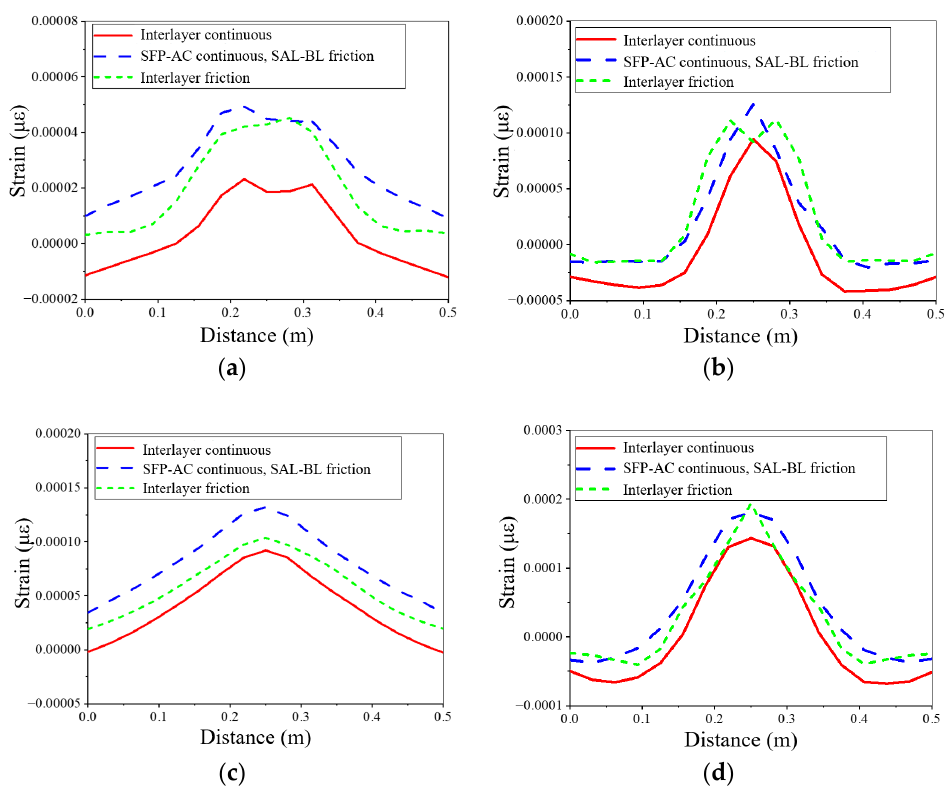
Figure 18. The effects of interlayer conditions on the dynamic responses of ART pavement. ( a ) The longitudinal strain at the bottom of SFP. ( b ) The transverse strain at the bottom of SFP. ( c ) The longitudinal strain at the bottom of AC. ( d ) The transverse strain at the bottom of